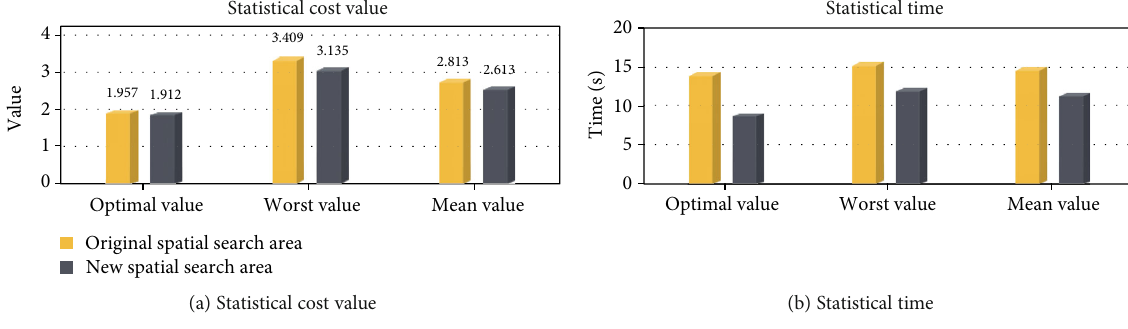
Figure 23: The comparative results for two di ff erent spatial search areas.